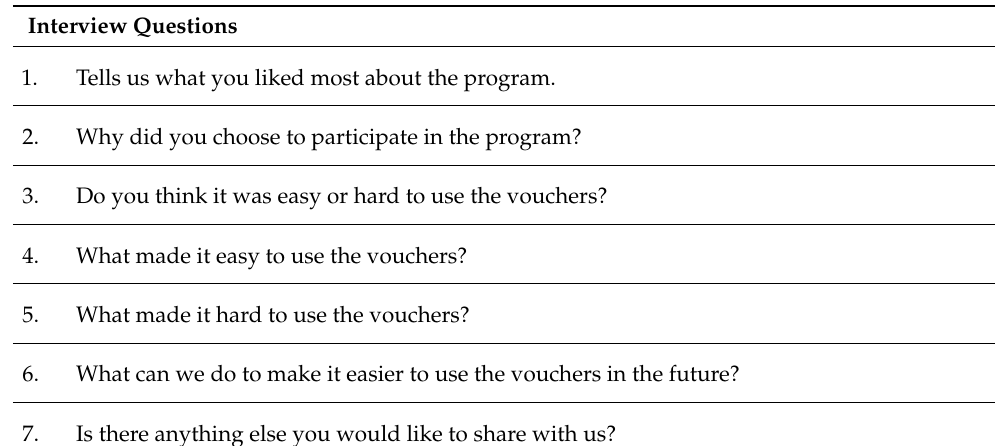
Table 1. Keiki (child) produce prescription (KPRx) Interview